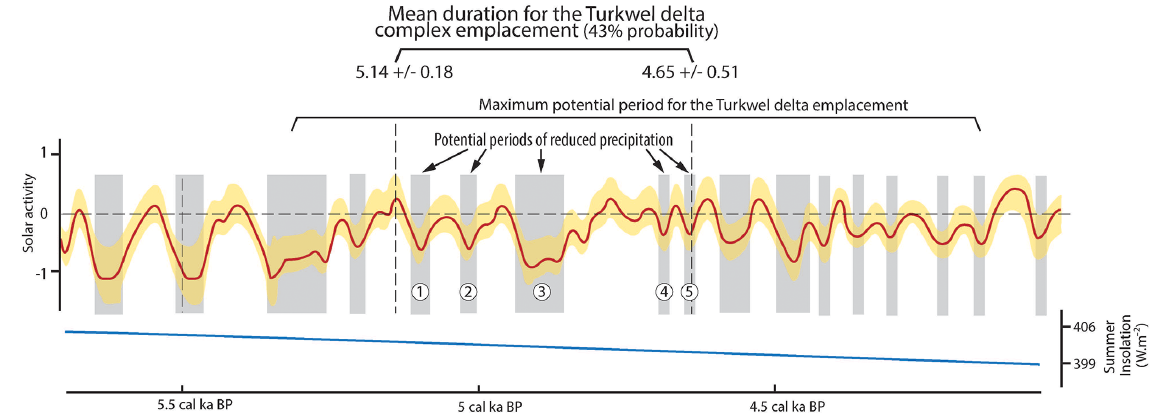
Figure 6. The red curve presents total solar irradiance (40-year moving average) relative to the value of the PMOD composite during the solar cycle minimum of the year 1986 (1365.57Wm − 2 ; Steinhilber et al., 2009) for the period contemporaneous with AHP regression of Lake Turkana. The shaded band (yellow) represents 1 σ uncertainty. The blue curve represents the precessional curve covering the same time period (http://www.imcce.fr/Equipes/ASD/insola/earth/online/). Grey stripes highlight solar activity